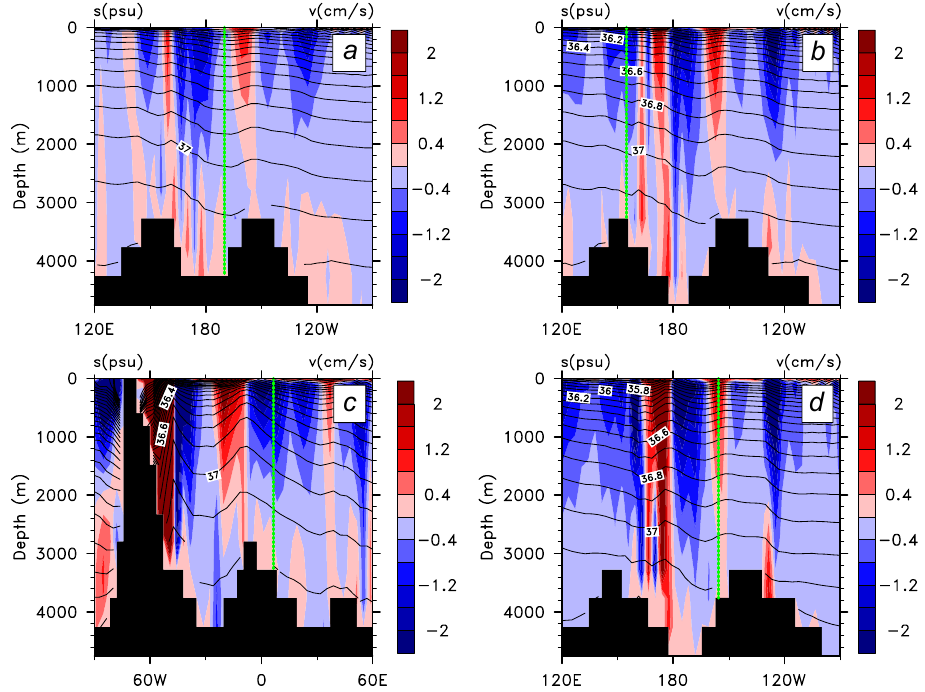
Figure 6. Zonal sections of salinity (contour in psu) and meridional velocity (shading in 10 − 2 m/s) along ( a ) 60.9 ◦ S, ( b ) 59.0 ◦ S, ( c ) 52.9 ◦ S and ( d ) 57.1 ◦ S at 22 ka BP. The locations of the four proxy cores are marked (green) on the zonal sections,